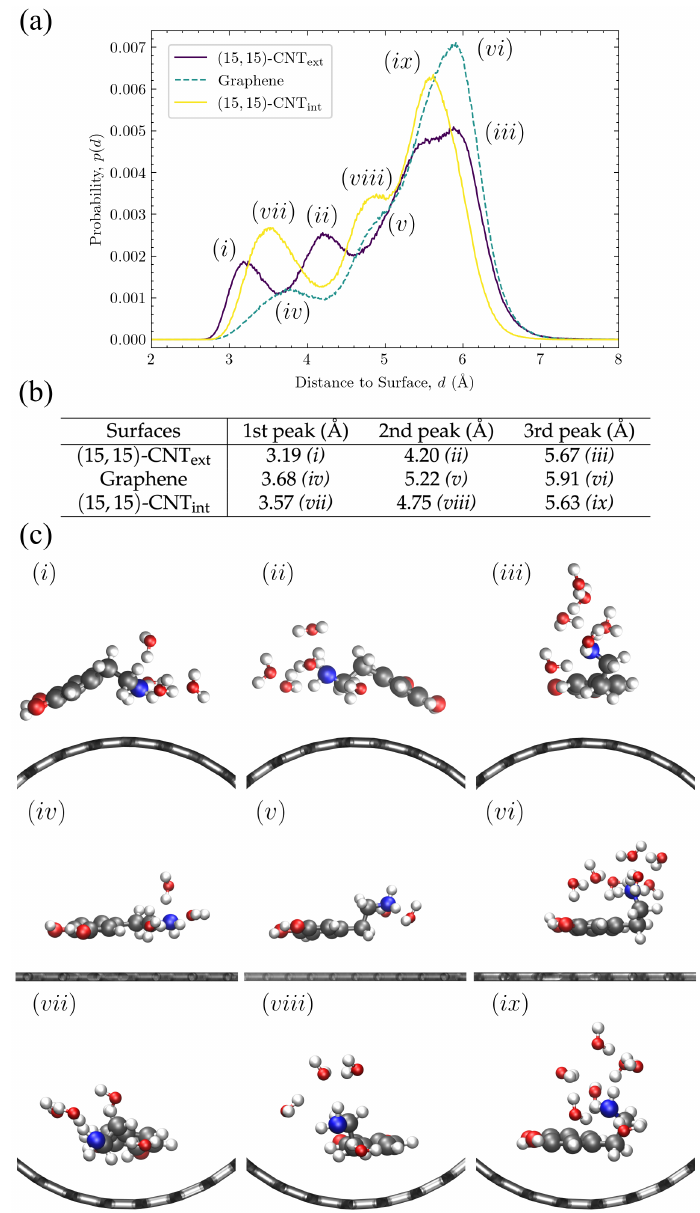
Figure 8. Vertical distributions and configurations of DA at the carbon:water interface. Panel ( a ) shows the vertical distributions of the amine group of DA on flat graphene and on the exterior and interior of a ( 15,15 ) -CNT. The three peaks in each distribution are labeled and correspond to the distances shown in panel ( b ) and the sample conformations shown in panel ( c ). Peak positions in ( b ) were obtained from curve-fitting using Gaussian functions. In panel ( c ), only water molecules within 3 Å radius of the nitrogen in the amine group are